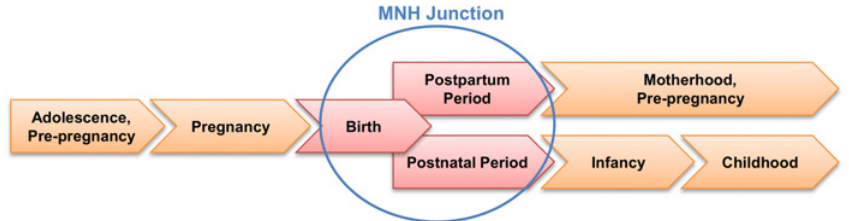
Fig 1. Continuum of Care and Maternal-Neonatal Health (MNH) Junction. Based on the Partnership for Maternal, Newborn & Child Health